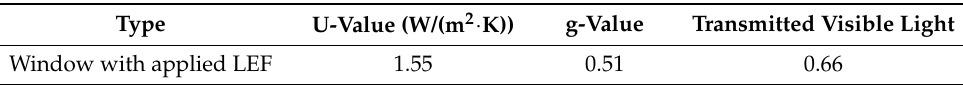
Table 6. Window data when LEF was